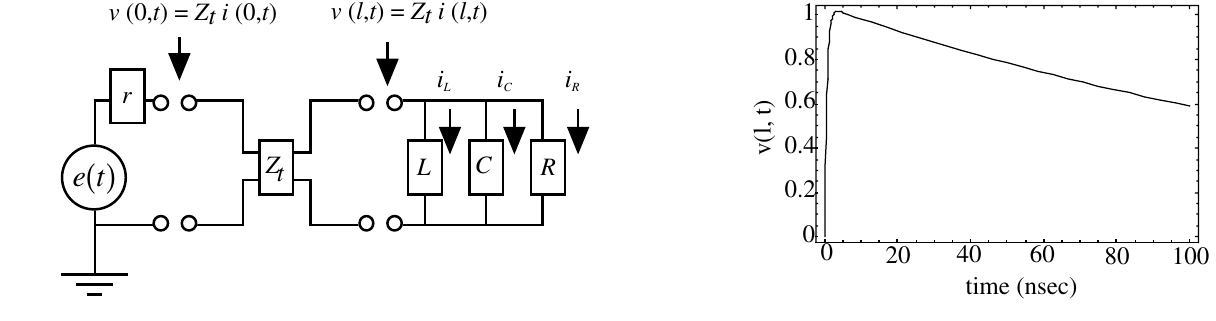
FIG. 3. Induced voltage (calculation), where V